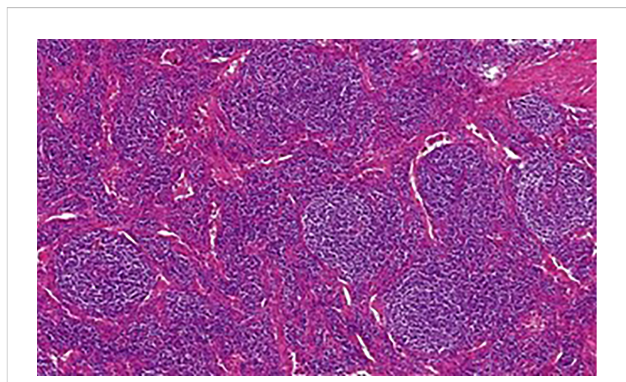
FIGURE 1 Castleman disease, hyaline-vascular type: Histology showed numerous enlarged follicles with abnormal germinal centers and with concentric layering of lymphocytes in the periphery of the follicles (onion-skin pattern of the mantle zone). Abnormal vascular proliferation and hyalinization was present within and in between the follicles.